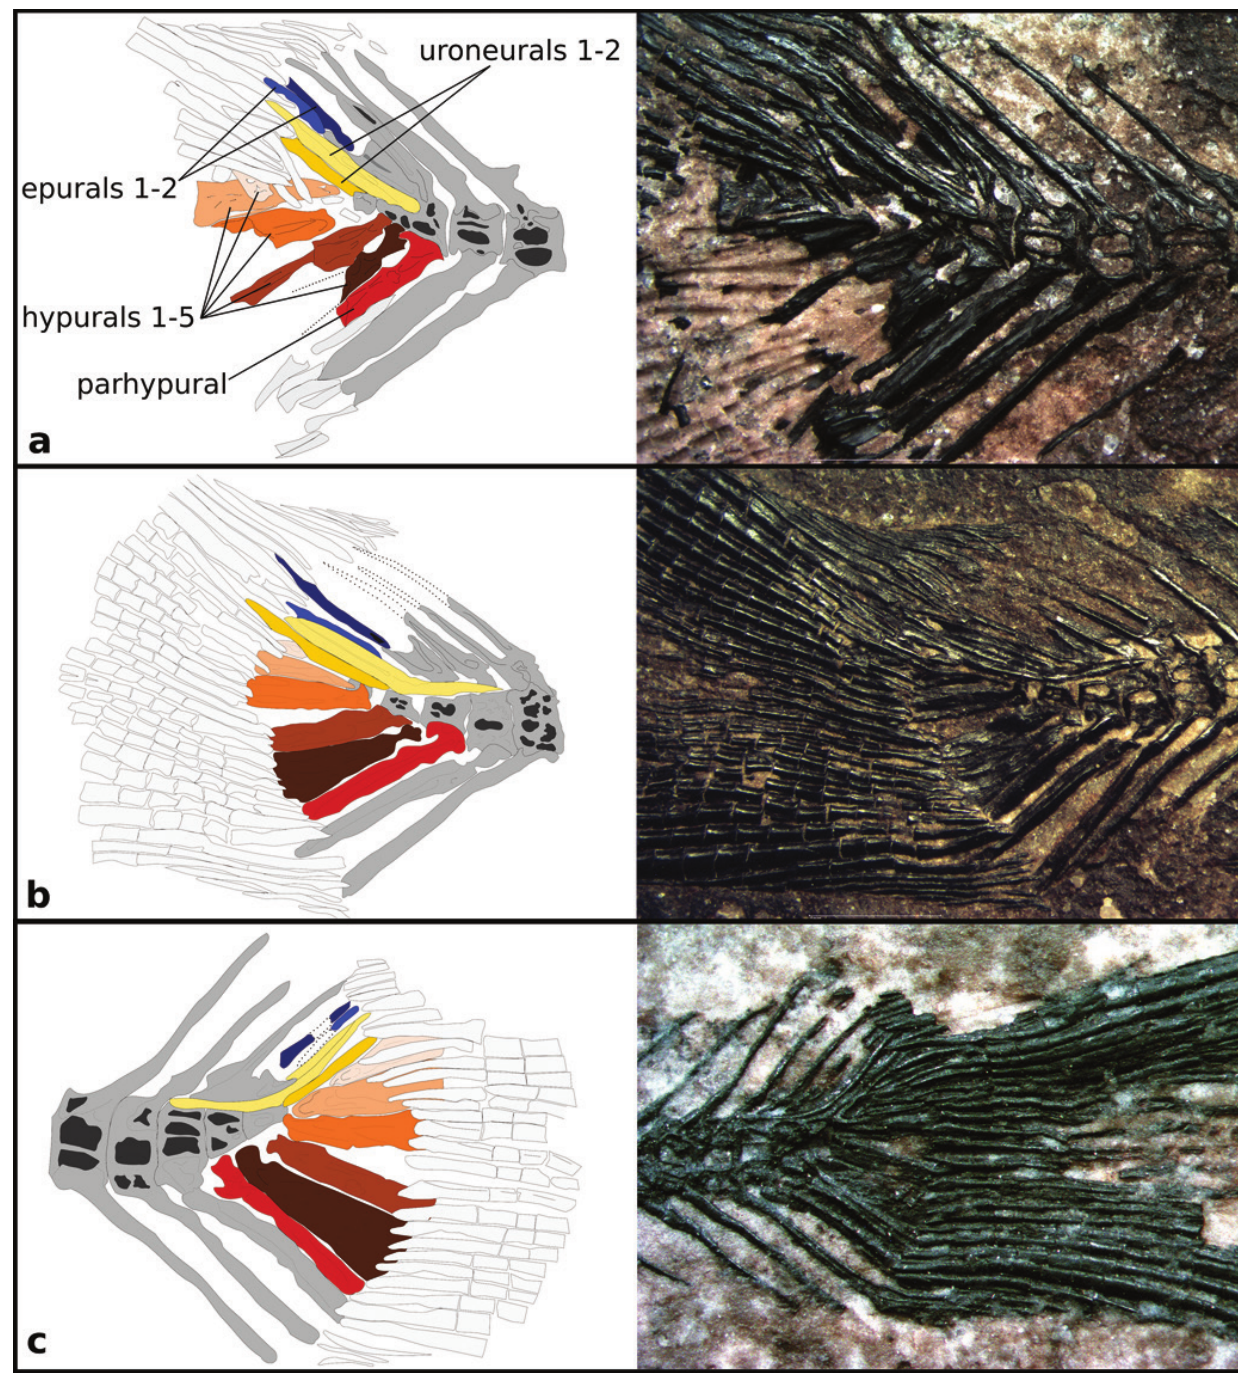
Fig. 9 . Caudal-fin skeleton in Dastilbe moraesi as observed in: a . specimen CPUFMT 746, 28.0 mm TFL, anterior to right; b . specimen CPUFMT 736, 37.0 mm TFL, anterior to right and c . specimen CPUFMT 748, 21.0 mm TFL, anterior to